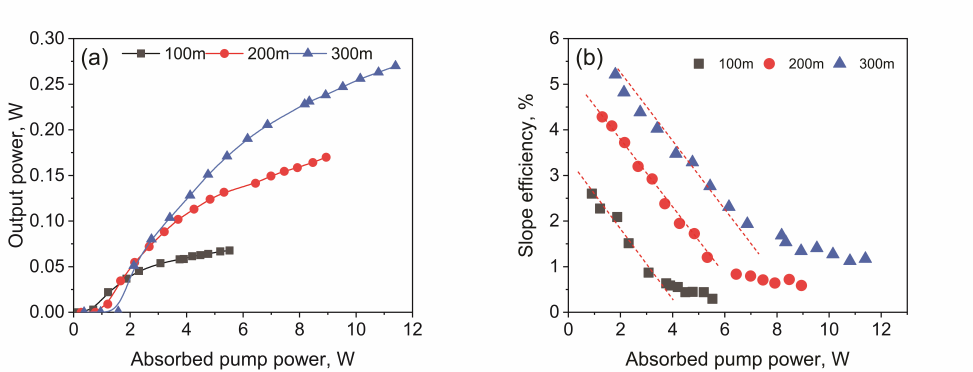
Figure 3. Output power ( a ) and slope efficiency ( b ) of BDFLs with the FBG as a function of the absorbed pump power. F3 with various lengths of 100, 200 and 300 m was used in the